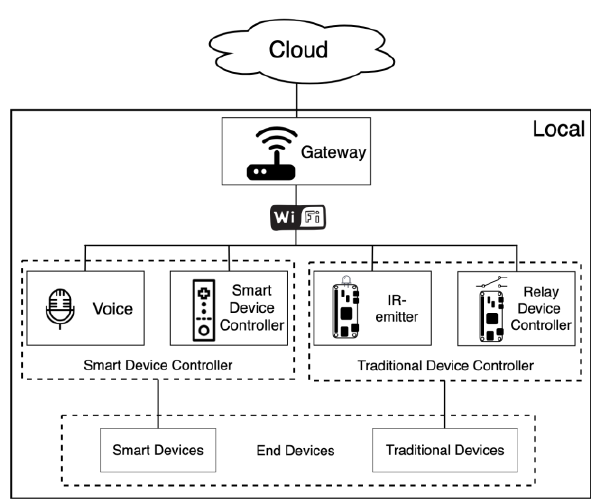
Figure 1. The proposed framework.